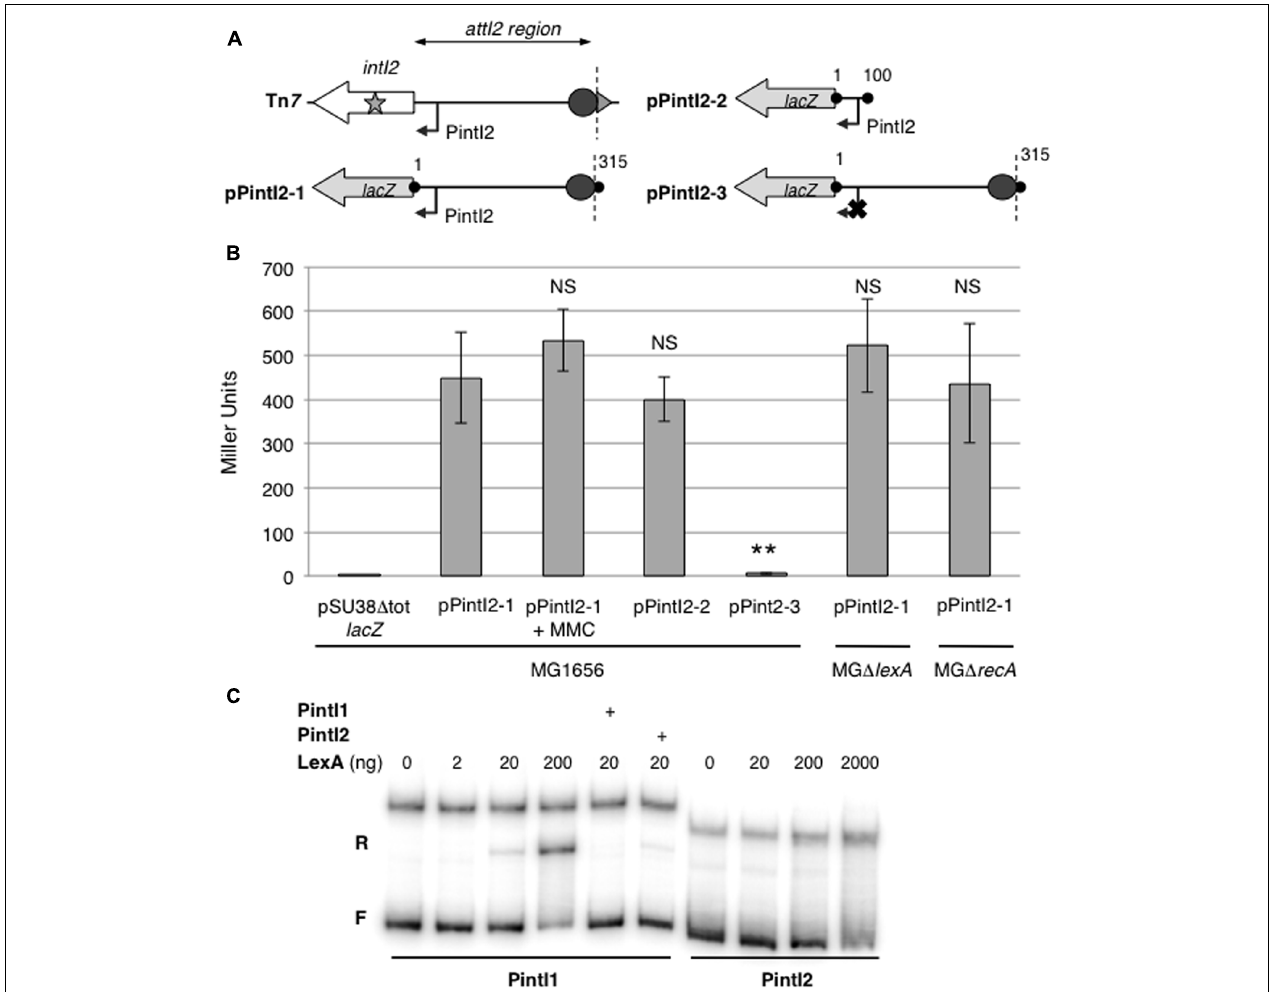
FIGURE 2 | Characterization and regulation of the P intI2 promoter. (A) Schematic representation of the class 2 integron carried on Tn 7 and PintI2- lacZ translational fusions with the entire attI2 site or P intI2 promoter only carried on plasmids pPintI2-1, pPintI2-2, and pPintI2-3 (pPintI2-3 carrying an inactive PintI2). Boundaries of the cloned fragment are indicated by black dots and numbered according to the attI2 region as shown in Figure 1B . The broken arrow represents the putative PintI2 promoter. The boundaries of the attI2 region (nt4-nt314) are marked by vertical dotted lines. The inactivating mutation of the -10 sequence of PintI2 is indicated by a cross. (B) The strength of the P intI2 promoter was measured in β -galactosidase assays with various P intI2 - lacZ translational fusions in the wild-type strain MG1656 and in its (cid:49) lexA and (cid:49) recA derivatives. MMC: One-hour incubation with 1.6 mg/mL mitomycin C. At least five independent assays were performed for each plasmid. Error bars indicate standard deviation. Student’s t -test was used for comparisons with MG1656/pPintI2-1: ∗∗ p < 0.01; NS p > 0.05. (C) Electrophoresis mobility shift assay with the native P intI1 and P intI2 promoters, in the presence or absence of purified LexA protein (amounts are indicated in nanograms). The + sign indicates competition experiments performed with an excess of cold PintI1 or PintI2 as indicated on the side of the graph. F, free DNA; R, specific retarded